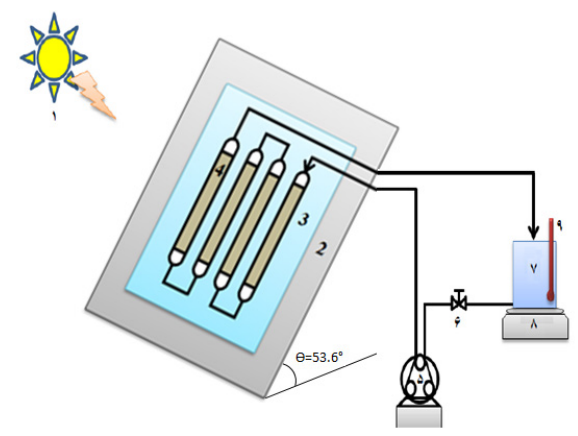
Figure 1. A schematic illustration of pilot used in the study: (1) sunlight; (2) wooden plate holder; (3) mirror; (4) photoreactors containing glass microbullets; (5) peristaltic pump; (6) flow valve and sampling; (7) tank containing naphthalene solution; (8) magnetic stirrer; and (9) alcohol thermometer.